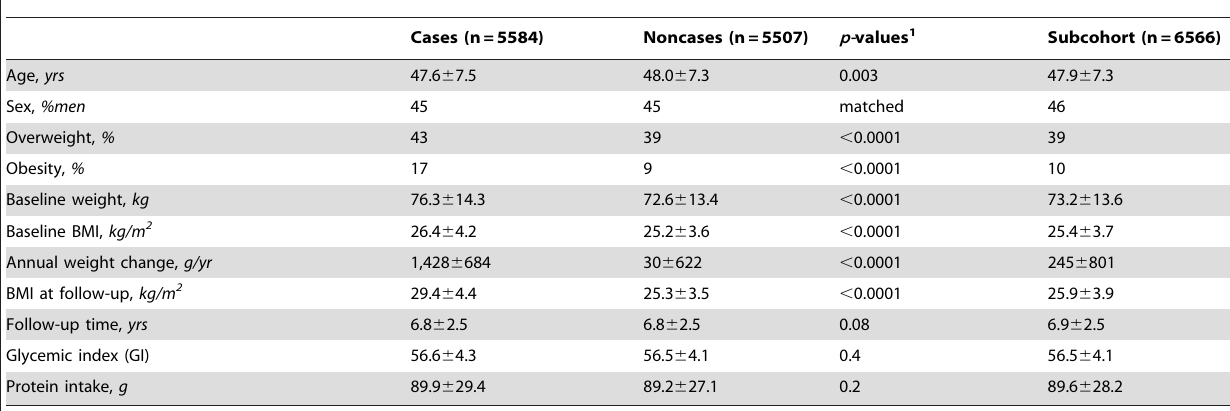
Table 1. Characteristics of participants of cases, noncases and